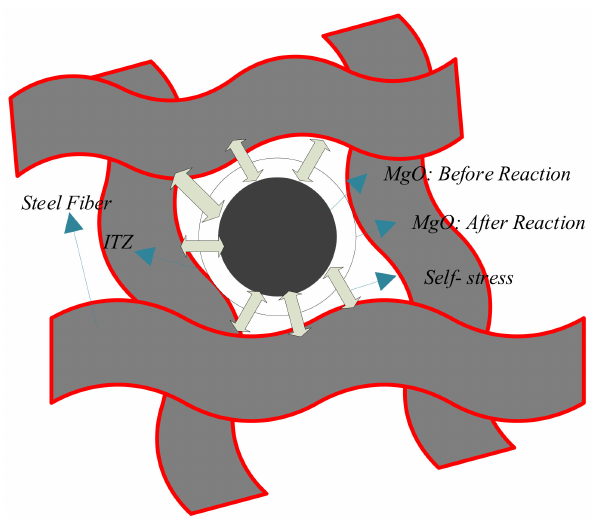
Figure 12. Self-stress caused by expansion extrusion at the